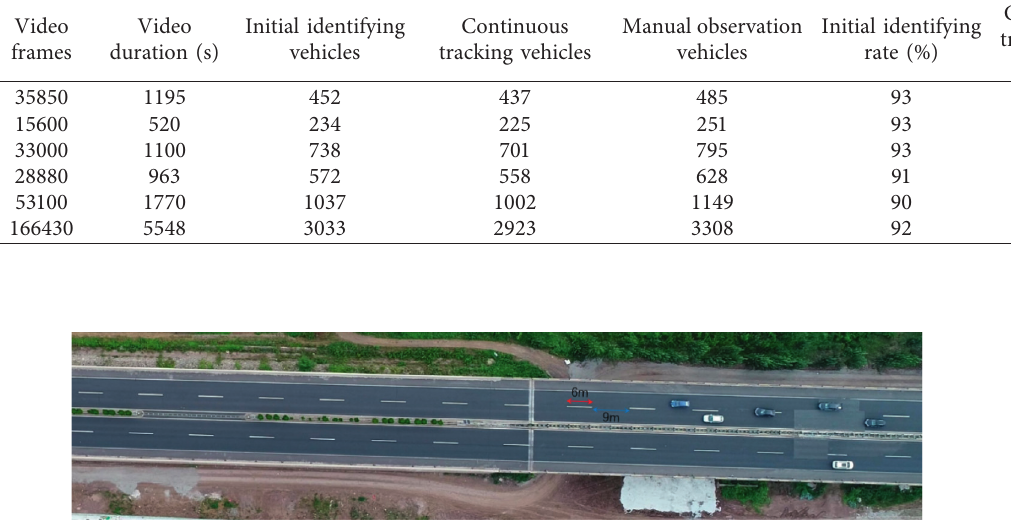
Figure 5: Distance of dividing line of highway in China.